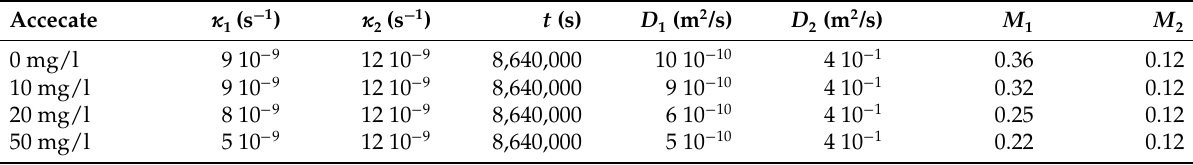
Table 2: Parameter values for Zn removal profile in case of carbon intrusion after 100 days.